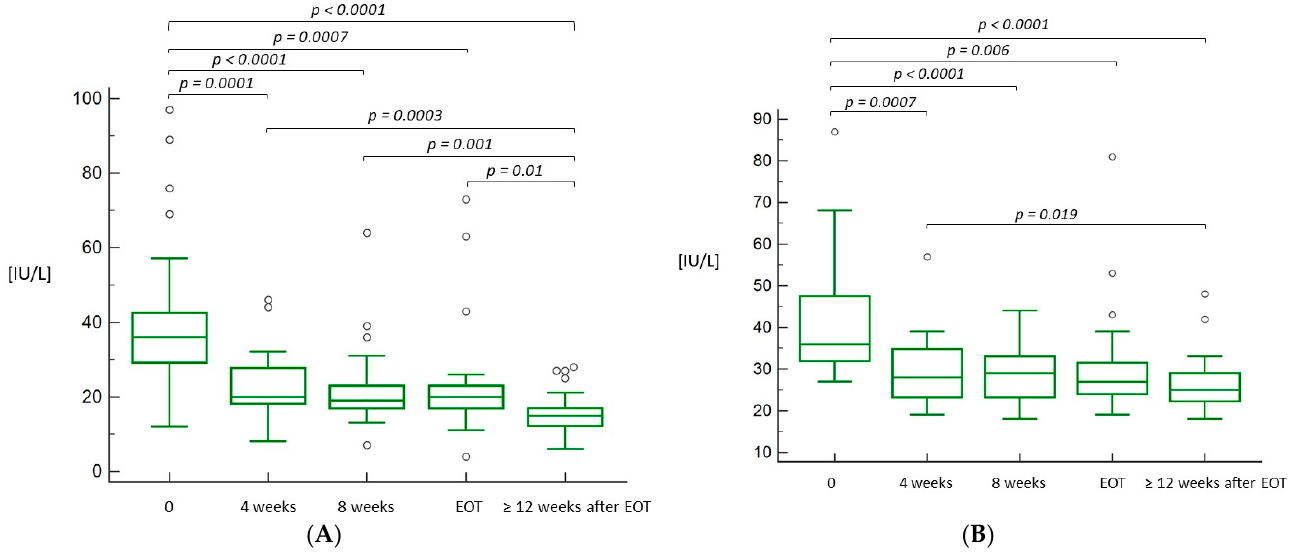
Figure 2. Box-and-whisker plots for alanine aminotransferase ( A ) and aspartate aminotransferase ( B ) levels during and after treatment with LDV/SOF. The top and bottom of each box are the 25th and 75th percentiles. The line through the box is the median, and the error bars are the maximum and minimum. ( A ) 0—start of treatment; EOT—end of treatment. ( B ) 0—start of treatment; EOT—end of treatment.